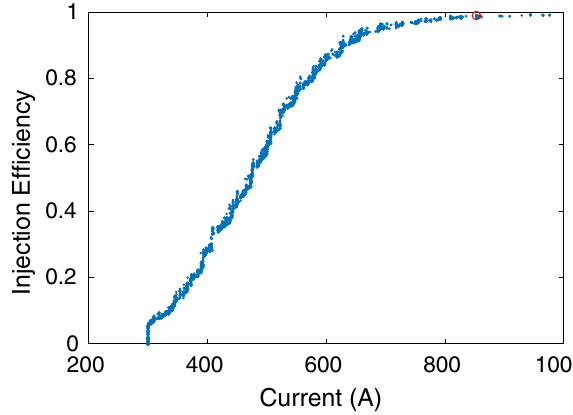
FIG. 9. A Pareto front from the ALS-U NLK injection optimization using MOGA. The 99% injection efficiency could be achieved with the solution marked by a red